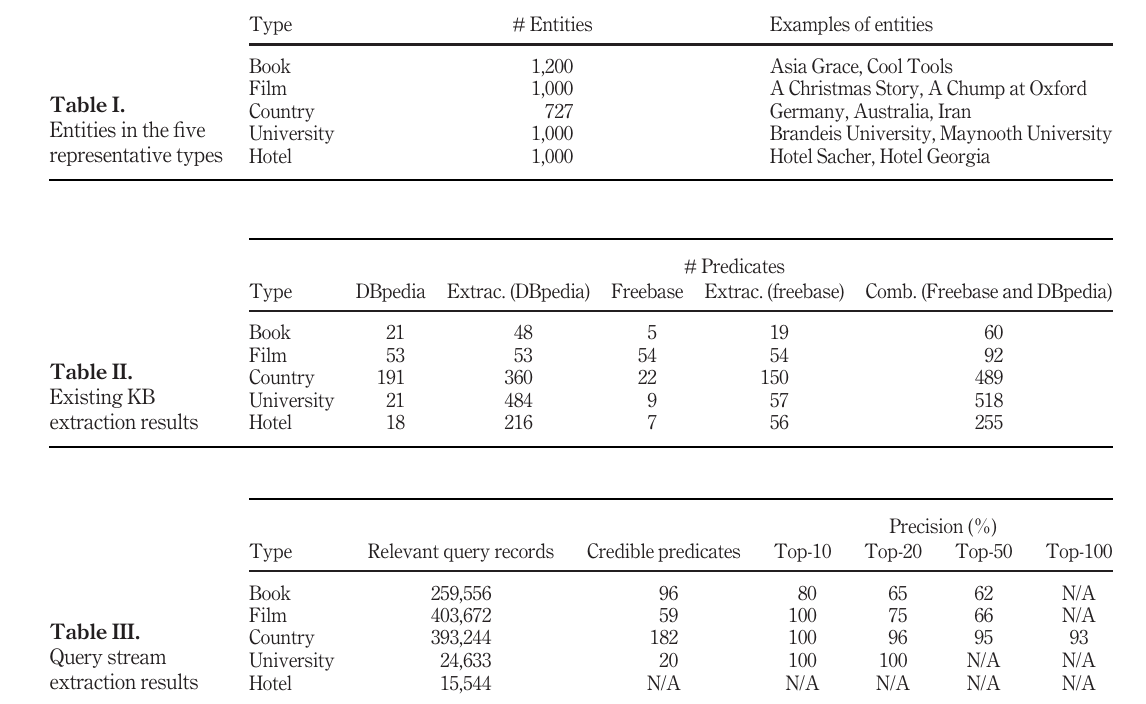
Table III. Query stream extraction results